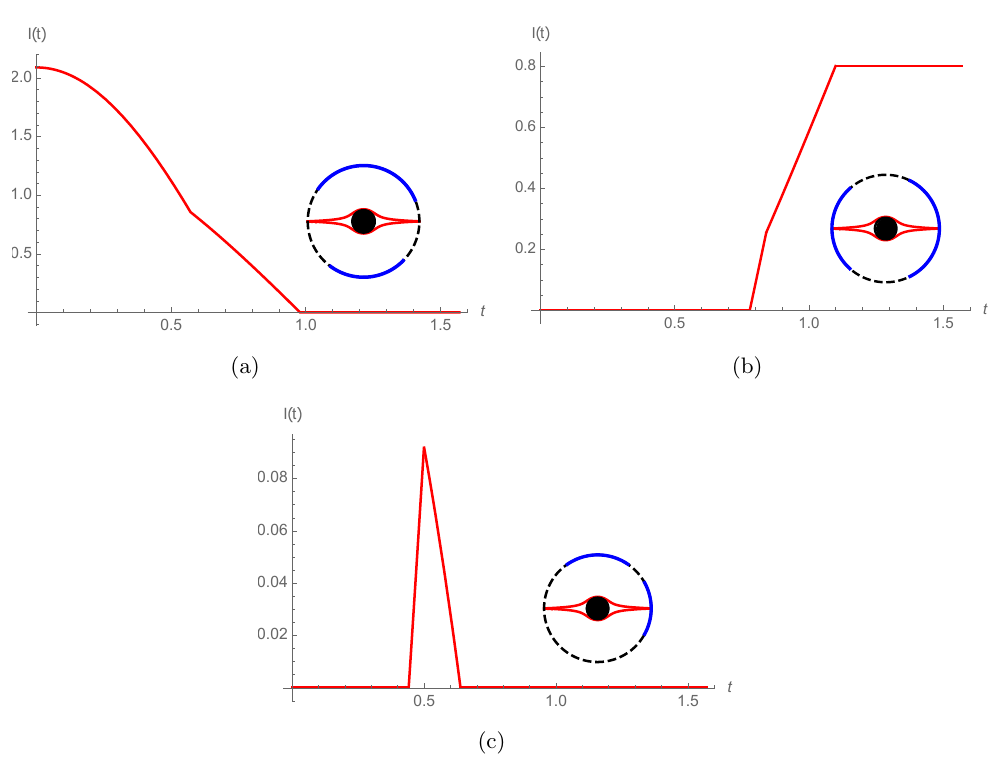
Figure 20 . Mutual information with dependence of time for di(cid:11)erent subsystems. Scales of subsystems: (a) (cid:1) ’ up = 27 (cid:25)= 40, (cid:1) ’ down = 9 (cid:25)= 20; (b) (cid:1) ’ left = 1 : 68, (cid:1) ’ right = 2 : 2; (c) (cid:1) ’ up = 1 : 2, (cid:1) ’ right =